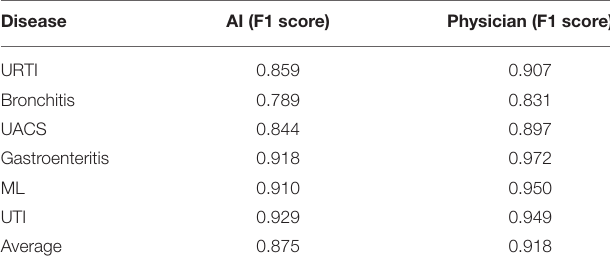
TABLE 2 | Diagnostic performance of the AI model and the physician for the dataset two ( n = 935).